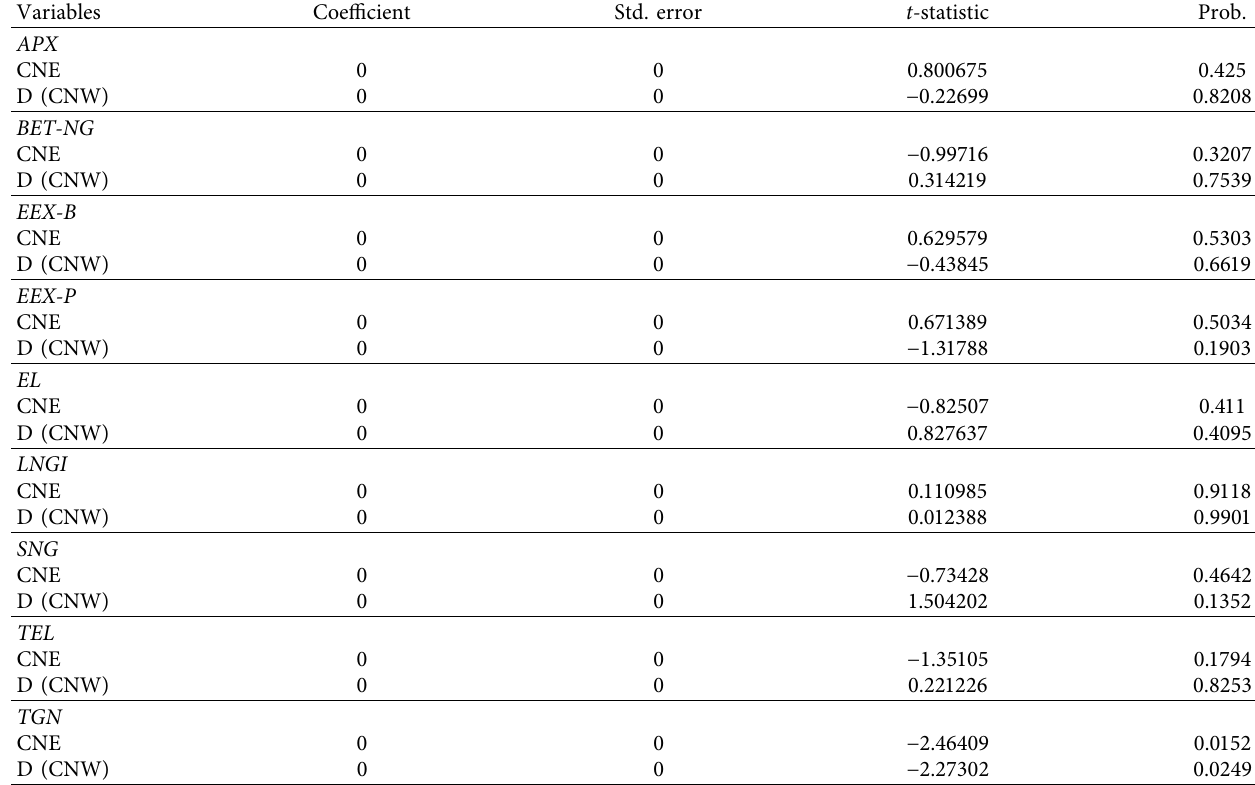
Table 9: ARDL long-term term coefficients.